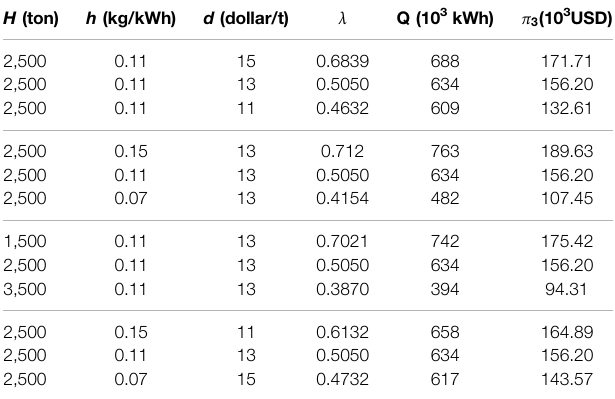
TABLE 5 | The probability λ of EPP implementation and its power saving Q and revenue π 3 under different H , h , and d